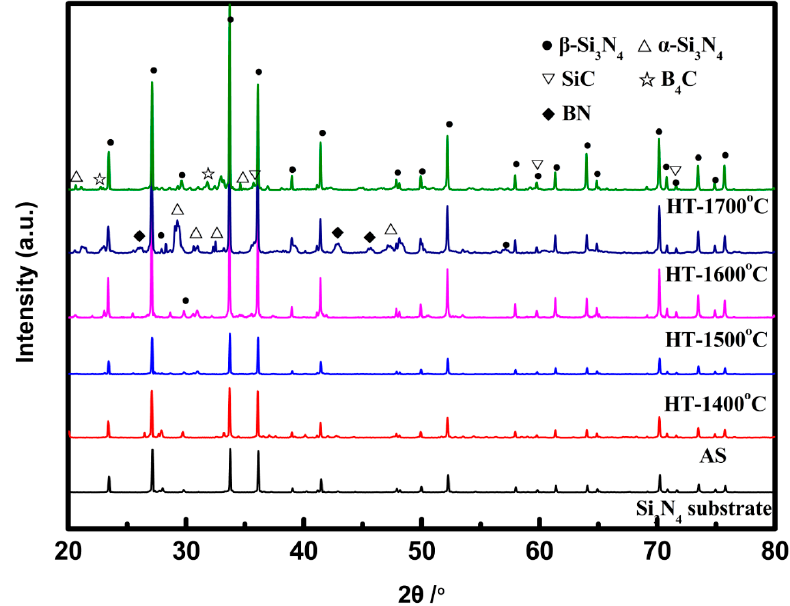
Figure 4. X-ray diffraction patterns of SiBCN-Si 3 N 4 ceramics with different heat-treatment